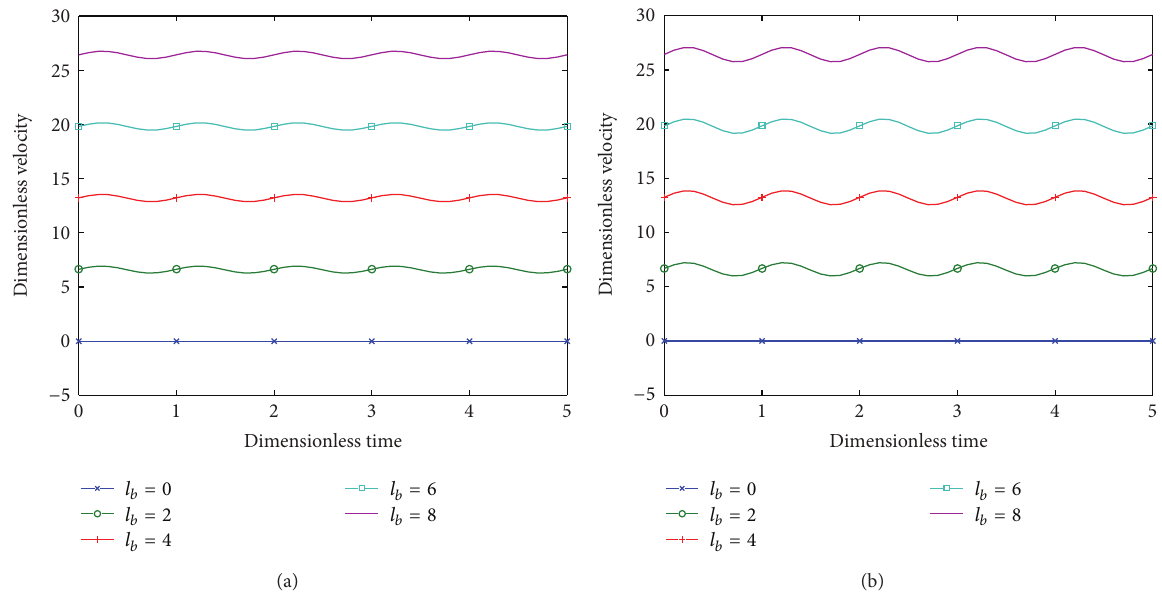
Figure 3: Diagrams showing the velocity profile on the arterial wall with five different slip parameters 𝑙 𝑏 for two different artery radii (a) 𝑟 = 0.15 cm; (b) 𝑟 = 0.5 cm.